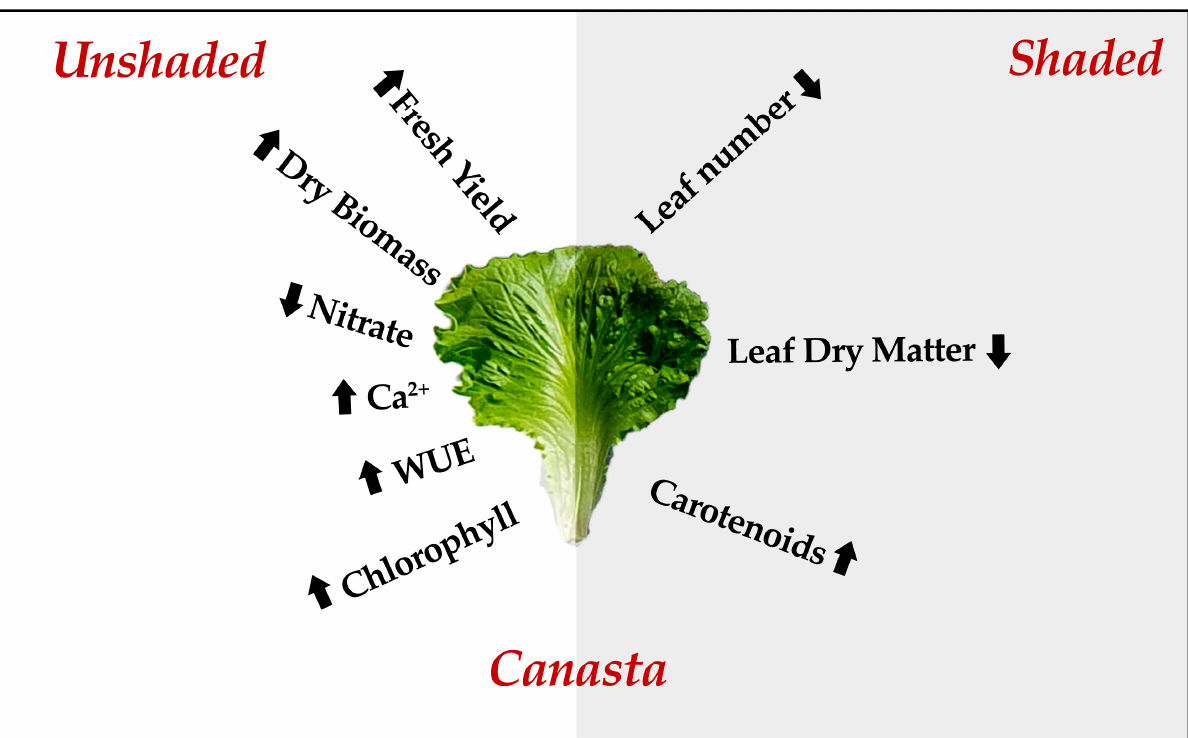
Figure 6. Schematic graphical representation of the productive and adaptive response of Lactuca sativa L. cv ‘Canasta’ grown under shaded and unshaded conditions in early summer season.